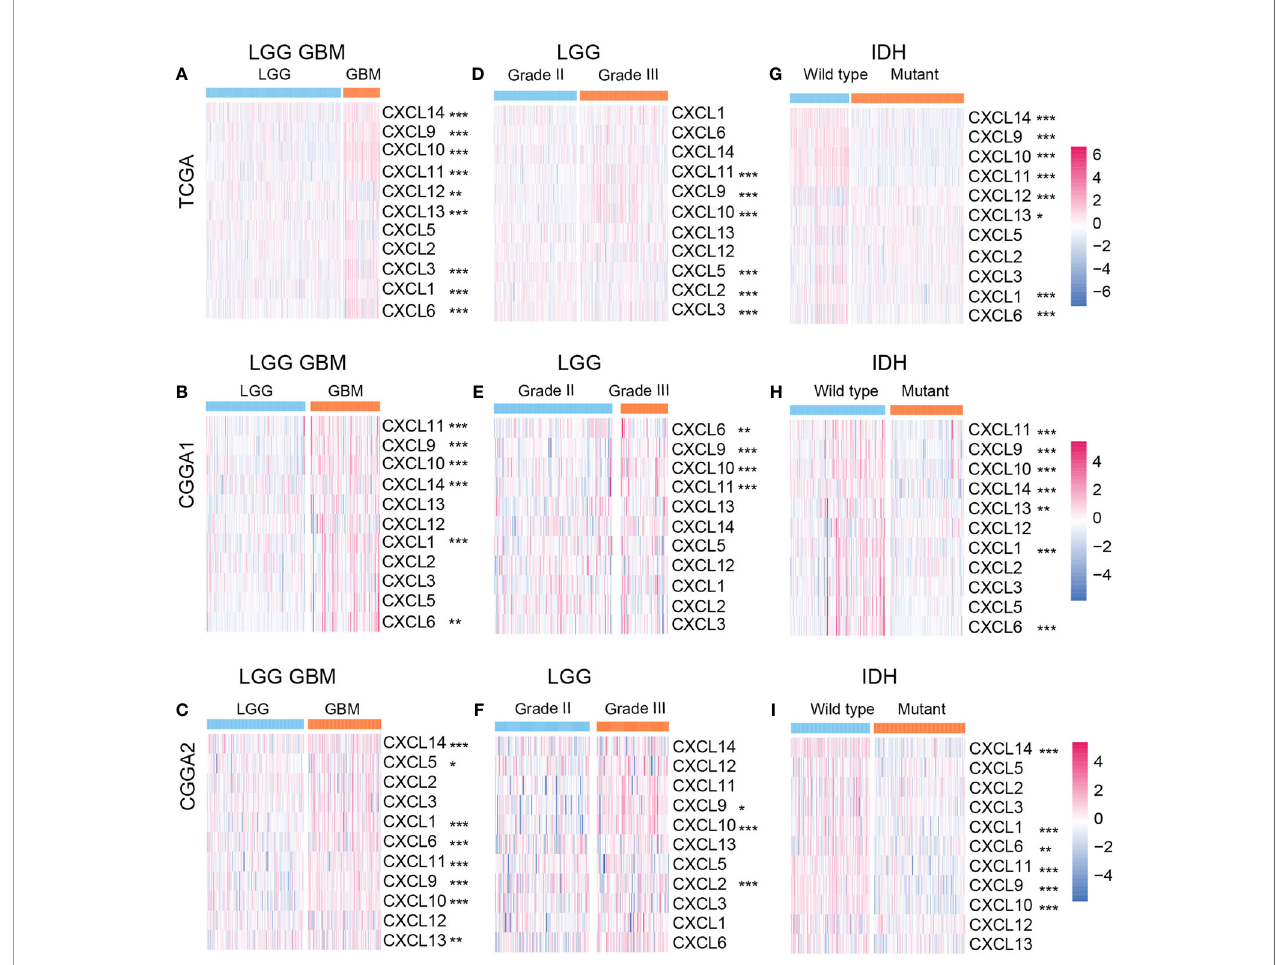
FIGURE 1 | Relationships between CXCL expression patterns and clinical characters of gliomas. The expression pro fi le of the CXCL family in the LGGGBM group (A) from the TCGA database and the validation cohort (B, C) . The heatmap of the CXCL family expression in LGG group (D – F) and GBM group (G – I) from the training and validation cohorts. *p < 0.05, **p < 0.01, ***p <